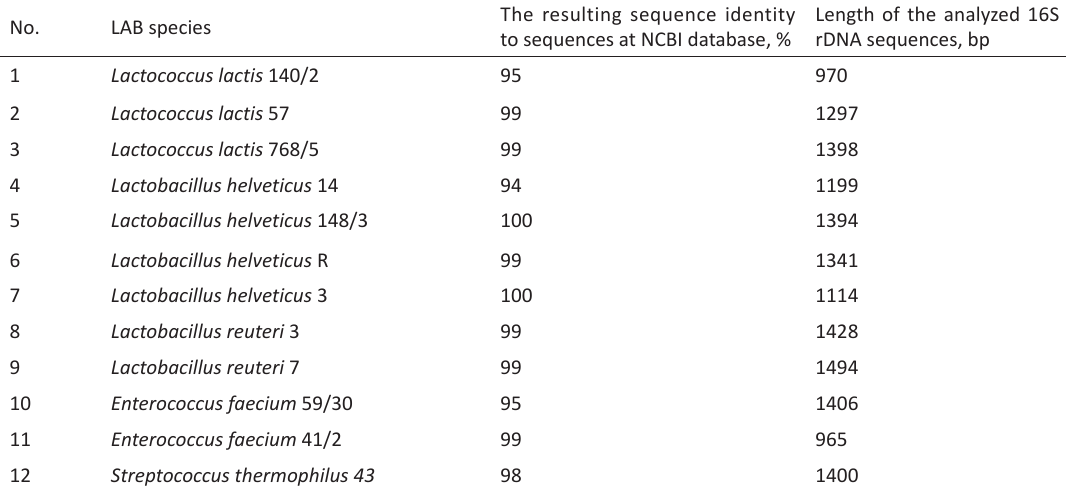
Table 2. LAB species used for investigations and parameters of their 16S rDNA sequences indicating the reliability of the identification No. LAB